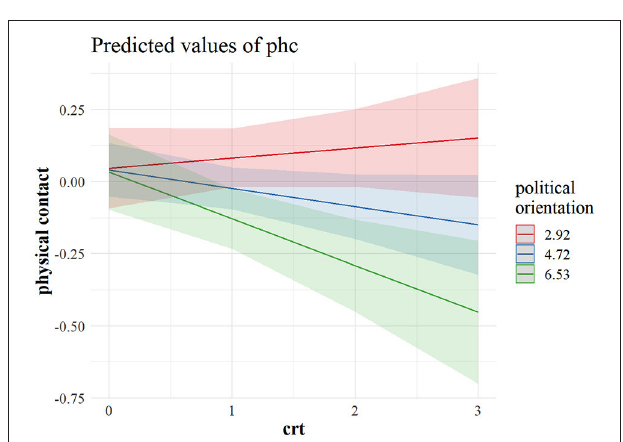
FIGURE 4 | Marginal predicted values for avoiding physical contact from a model interacting CRT and political orientation in the Canadian sample ( n = 740). The predictor values for left (2.29), centrist (4.72), and right (6.53) political orientation are ± 1 SD . CRT values (0–3) indicate the number of correct responses. phc, avoiding physical contact; crt, cognitive